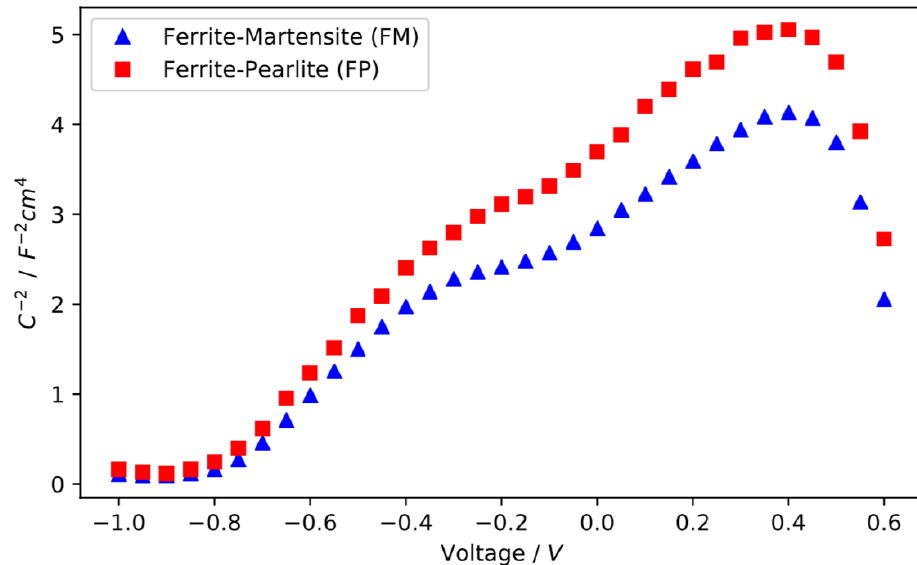
Figure 6. Mott–Schottky plots for the passive film formed on different microstructures for 6 h at 0.2 V (vs. Ag/AgCl) in 0.1 M NaOH solution at a frequency of 1 kHz.